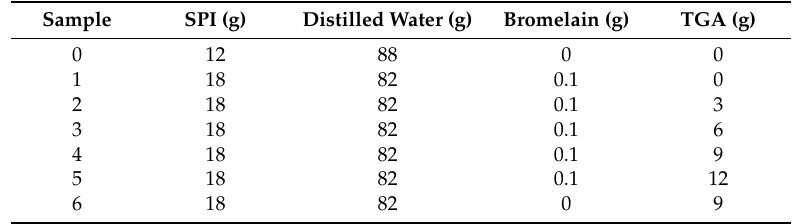
Table 1. Various adhesive formulations. SPI—Soy protein isolate; TGA—Triglycidylamine. Sample SPI